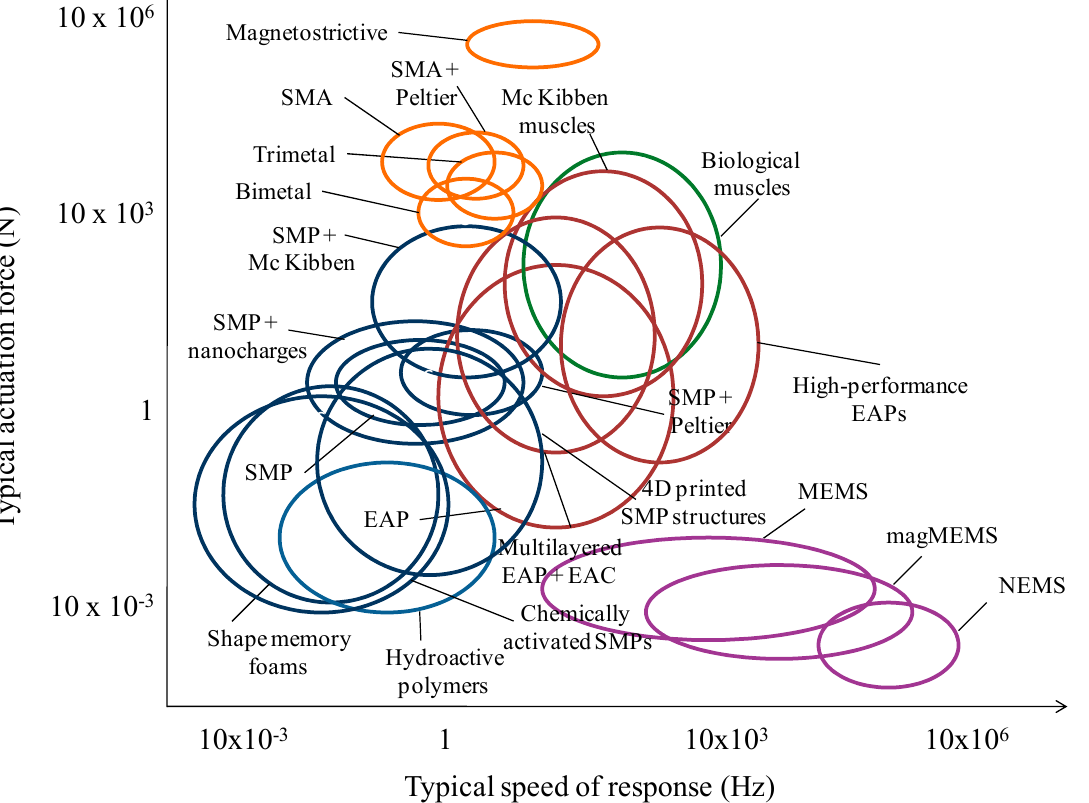
Figure 1. Usual actuation force vs. speed of response for actuators based on “smart” materials. Abbreviations: EAC, electroactive (normally piezoelectric) ceramics; EAP, electroactive polymers; SMP, shape-memory polymers; SMA, shape-memory alloys; MEMS, microelectromechanical systems; magMEMS, Magnetic microelectromechanical systems; NEMS, nanoelectromechanical systems. Adapted and updated from study by our team [23].